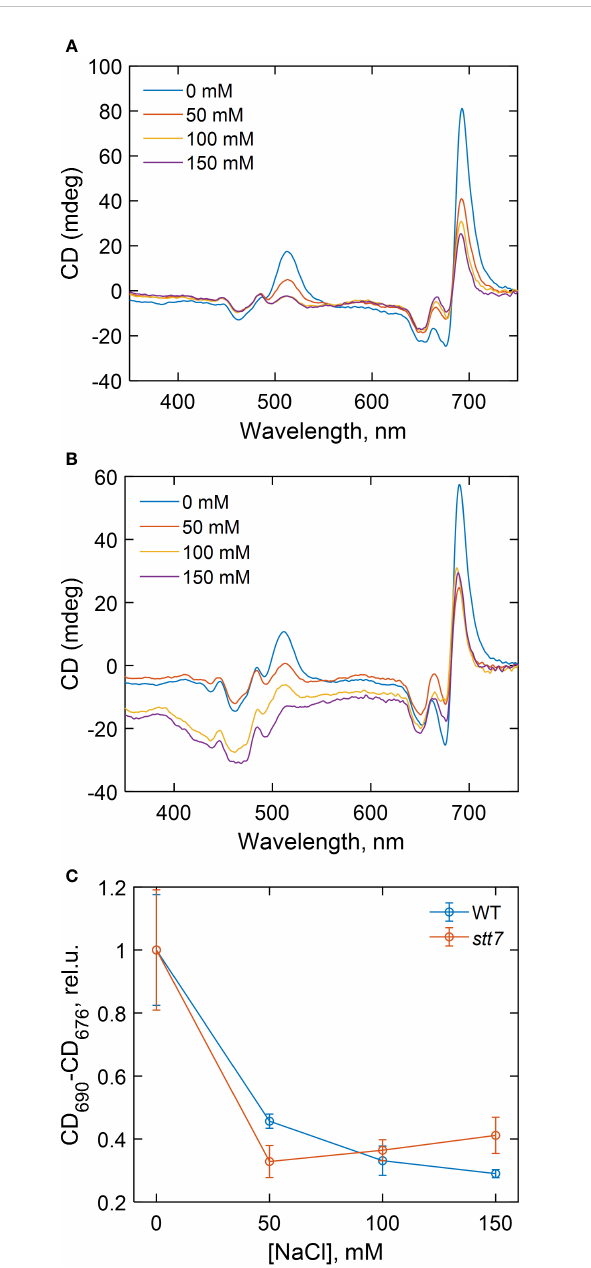
FIGURE 5 Circular dichroism spectra of (A) wild type (WT) and (B) state transition kinase 7 ( stt7) C. reinhardtii cells grown under different salinity concentrations, as indicated, and (C) dependence of the total amplitude of the psi-type circular dichroism (CD) bands in the red spectral region (CD 690 -CD 676 ) on the salinity of the growth